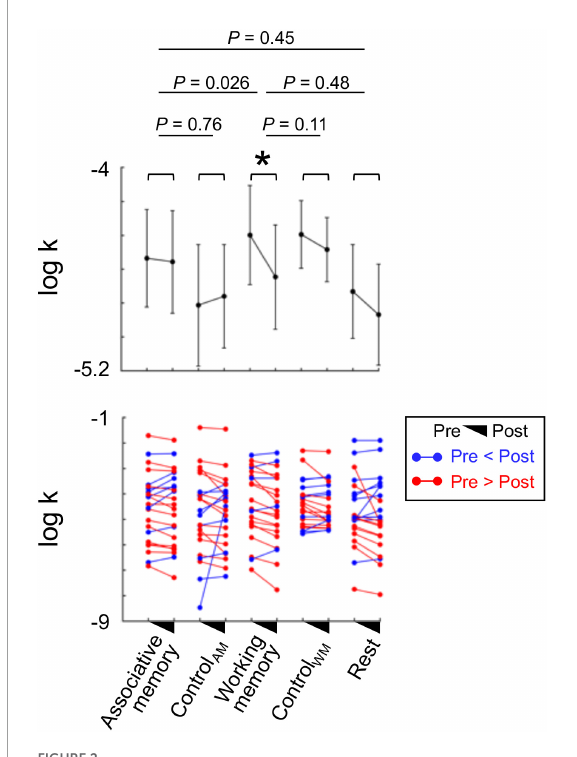
FIGURE2 Impacts of the intervention tasks on reducing individuals’ impulsivity (experiment 1). Each participant group was given a different type of intervention task. To examine whether each intervention had an impact on individuals’ impulsivity, we calculated changes in individuals’ delay discount rates ( k ) by comparing their behavioral patterns during the intertemporal choice (ITC) task conducted before and after the intervention task. The individuals showed significantly reduced impulsivity after participating in the working memory task [paired t -test, t (20) = 3.44, P = 0.0026, Cohen’s d = 0.75, bootstrapping P = 0.0031]. On the contrary, the individuals who participated in other intervention tasks did not show the same pattern (i.e., reduced impulsivity) (all bootstrapping p s > 0.05). The mean discount rate change in the individuals who participated in the working memory task was larger compared with that in the individuals who were assigned to the associative memory task in between two ITC tasks [independent-sample t -test, t (42) = –2.31, P = 0.026, Cohen’s d = –0.35, bootstrapping P = 0.026]. The impact of the working memory task was